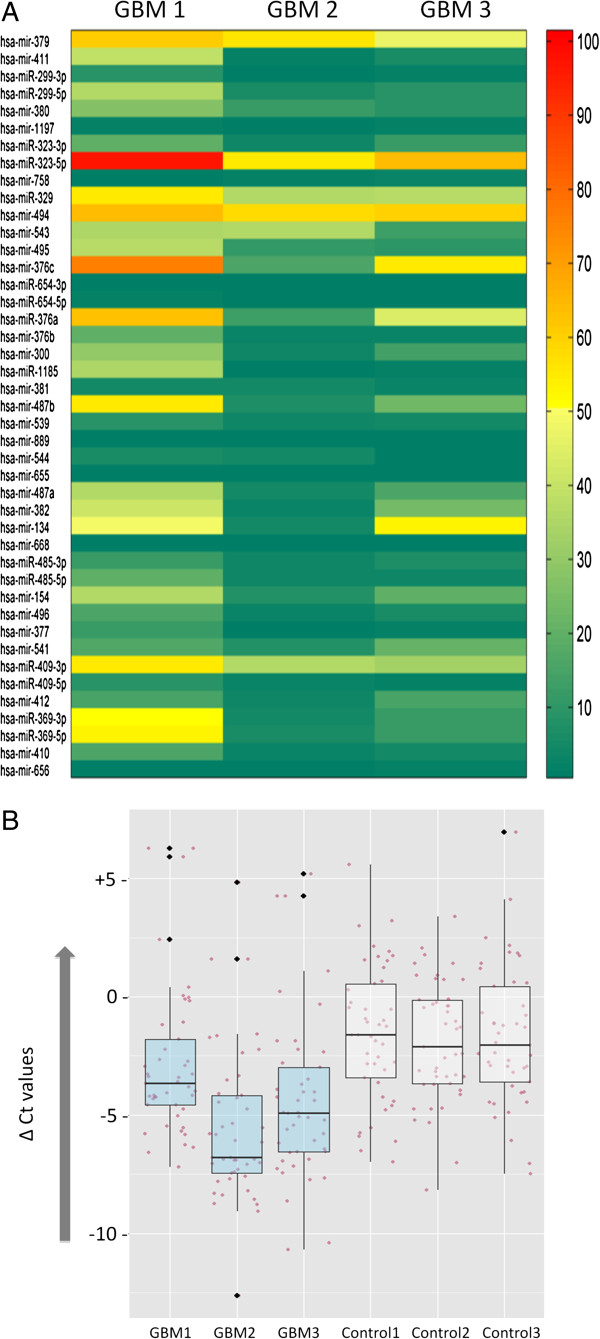
Real-time PCR validation of C14 downregulation in GBM. A) The heat map shows the fold changes (calculated by ΔΔCt method) of the respective miRs of C14 in 3 GBM cases with respect to the controls. Fold change <= 0.6 is taken as down-regulation (green) and >=2 is taken as upregulation (red), whereas, the intermediate values are considered to have non-differential expression (yellow) between the samples. As depicted for all the three GBM samples, 79% (34/43) of C14 miRNAs were found to be >40% downregulated in GBM. B) The box plots show the median distribution of ΔCt values of the C14 miRs in each of the sample. The GBM samples show distinctive lower median value as compared to the controls. The jitter-plot shows the total data distribution (ΔCt) in each sample.